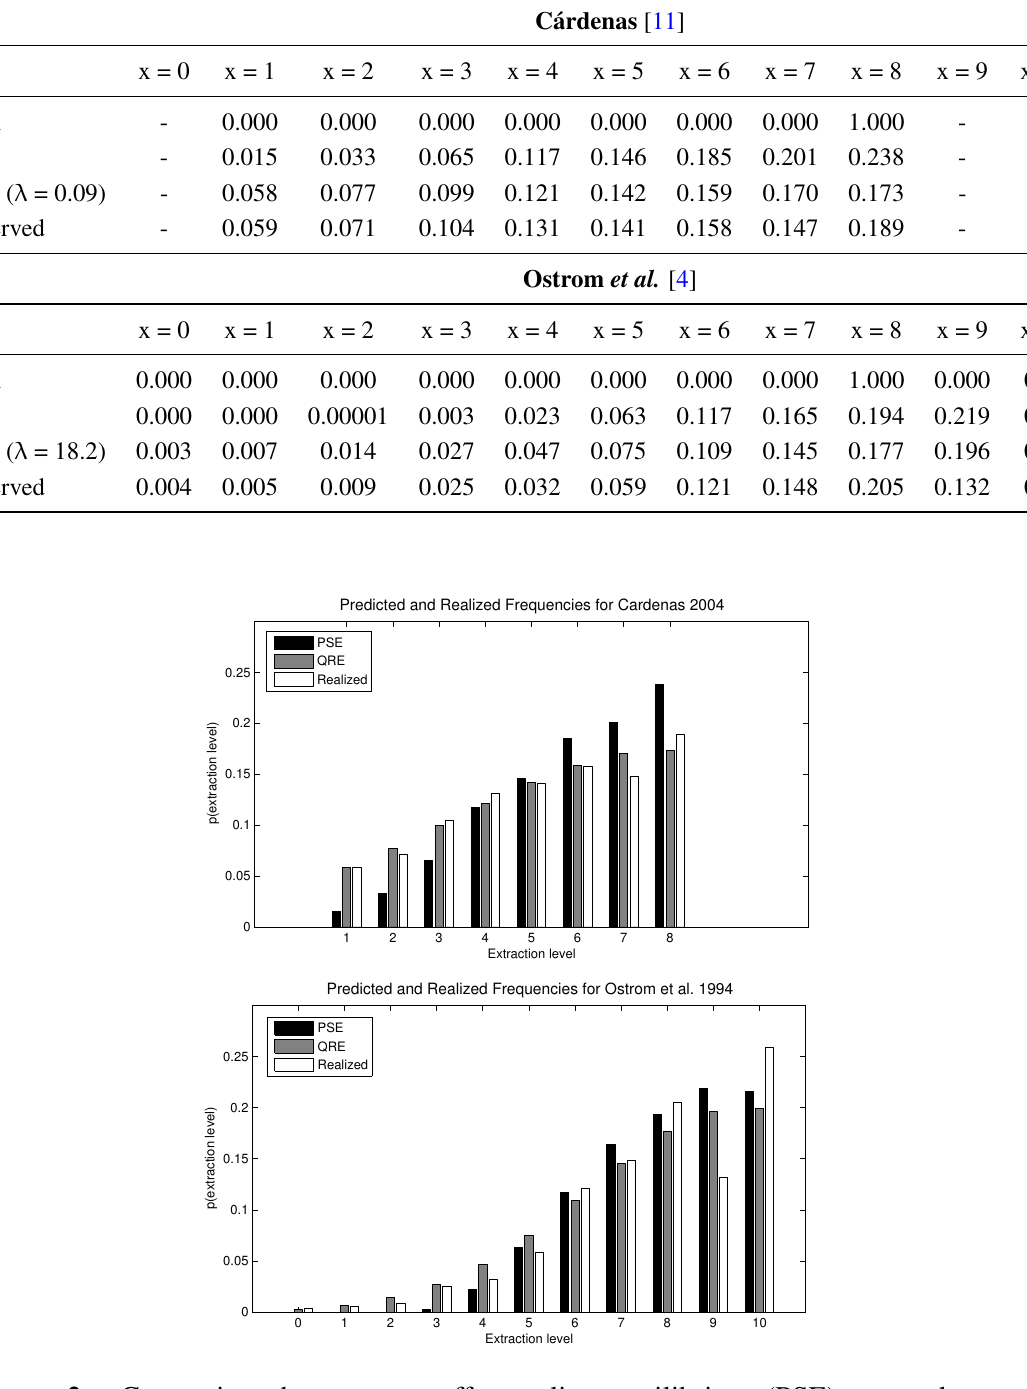
Figure 2. Comparison between payoff sampling equilibrium (PSE), quantal response equilibrium (QRE) and experimental